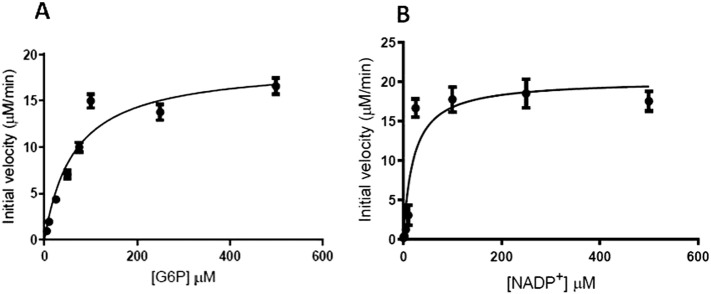
Representative kinetic plots of G6PDMahidol for A) G6P and B) NADP+.